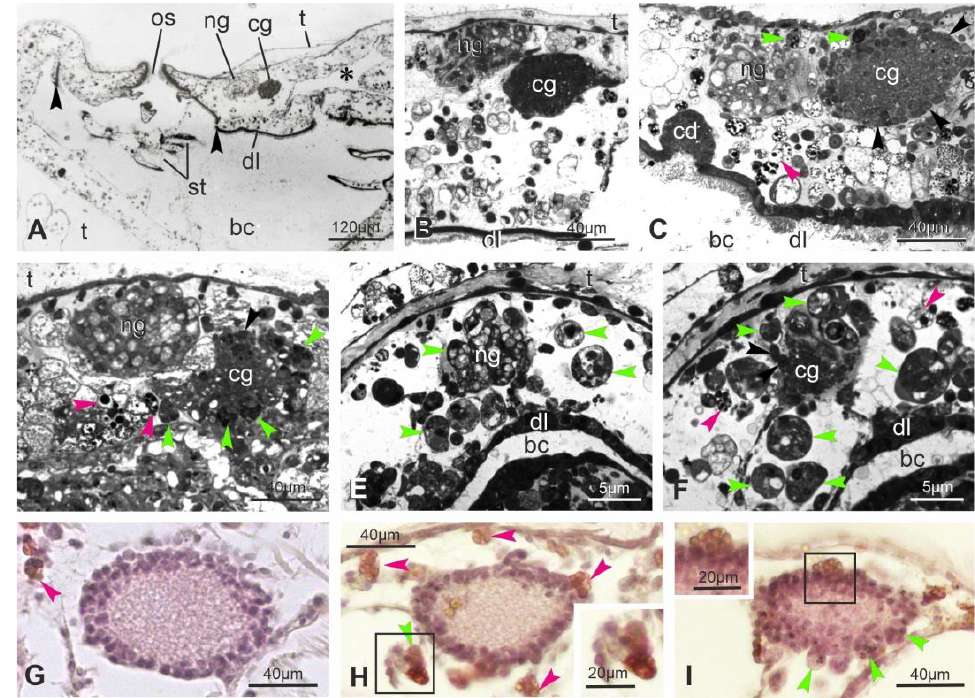
Figure 2. ( A ) Sagittal medial section of an adult filter-feeding zooid (mid-cycle), showing the neural complex located posteriorly to the oral siphon (os). In the neural complex, the neural gland (ng) is dorsal to the cerebral ganglion (cg). The neural gland duct, the dorsal tubercle, and the dorsal organ are not in the section. The asterisk points to the crossroad between the intersiphonal sinus and the dorsal sinus. Anterior at left; dorsal at top. Toluidine blue. arrowheads: peripharyngeal band; bc: branchial chamber; dl: dorsal lamina; st: stigmata; t: tunic. ( B – F ) Details of sagittal ( B – D ) and cross ( E , F ) sections showing the neural complex during takeover, at sub-stages 11 1 ( B ), 11 2 ( C ), 11 3 ( D ) and 11 4 ( E , F ). First signs of epithelial disorganization are recognizable in the dorsal lamina (dl) close to the complex at the beginning of takeover ( B ). The cerebral ganglion (cg) decreases progressively in size and number of neurons (black arrowheads). The neural gland (ng) maintains its vacuolated structures until advanced takeover. Note the increasing number of immunocytes, phagocytes (green arrowheads) and morula cells (pink arrowheads), close to the degenerating neural complex. Tolui- dine blue. bc: branchial chamber; cd: ciliated duct of the neural gland; dl: dorsal lamina; t: tunic. ( G , H ) Cross paraffin sections of the cerebral ganglion in adult filter-feeding zooids (mid-cycle) ( G ), and at sub-stages 11 1 ( H ) and 11 2 ( I ) to show the increase in number of immunocytes, phagocytes (green arrowheads, inset in H ) and morula cells (pink arrowheads, inset in I ), close to it and infil- trated among neurons. Hematoxylin and eosin. In the following takeover hours (sub-stage 11 2 ; Figures 1A,B,E and 2C), there are still no significant changes in the neural complex histology. Nonetheless, the zooid contraction dislocates the complex components, such that the body gland can be found anterior to its